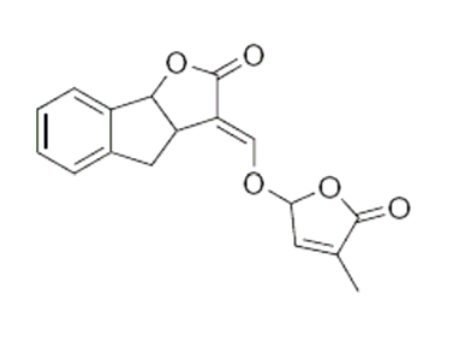
Figure 2. Chemical structure of the synthetic strigolactone analogue